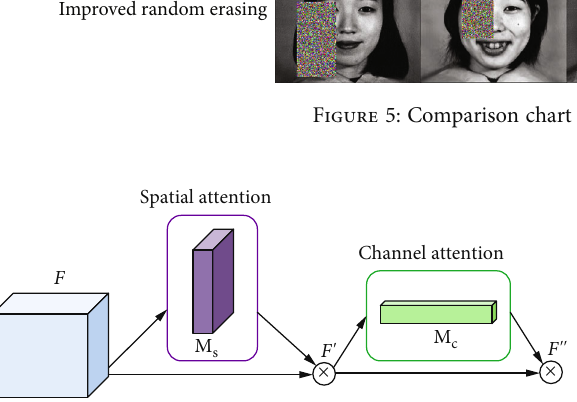
Figure 6: Scam overall attention